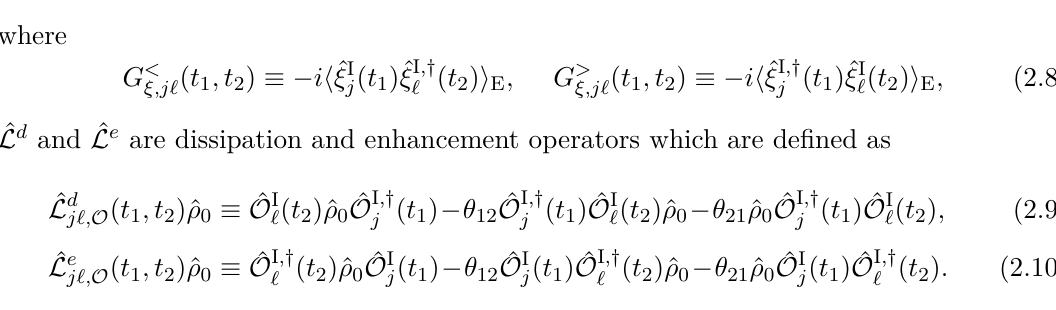
Figure 1 . Diagrammatic illustration of eq.